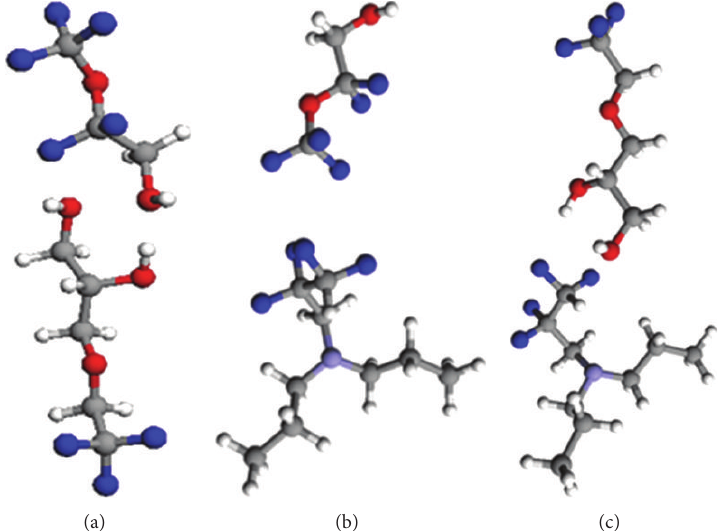
Figure 4: Blended relaxed lubricant dimers for (a) Z-dol-Z-tetraol, (b) Z-dol-DDPA, and (c) Z-tetraol-DDPA. Red: oxygen, purple: nitrogen, blue: fluorine, grey: carbon, and white: hydrogen.